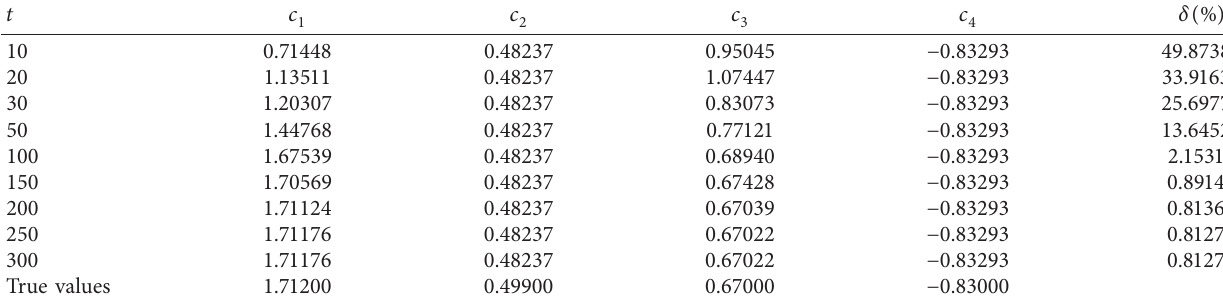
Table 1: The MT-SG estimates and errors.